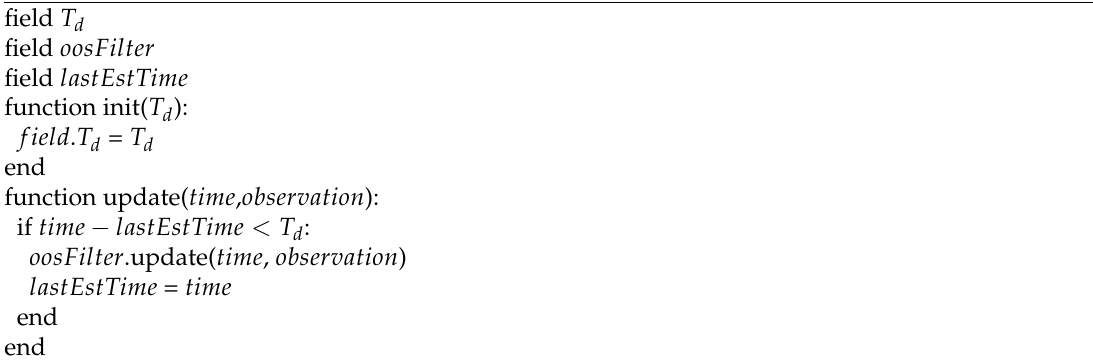
Algorithm 2 A selective filter uses an existing out-of-sequence filter to incorporate observations that are newer than a fixed